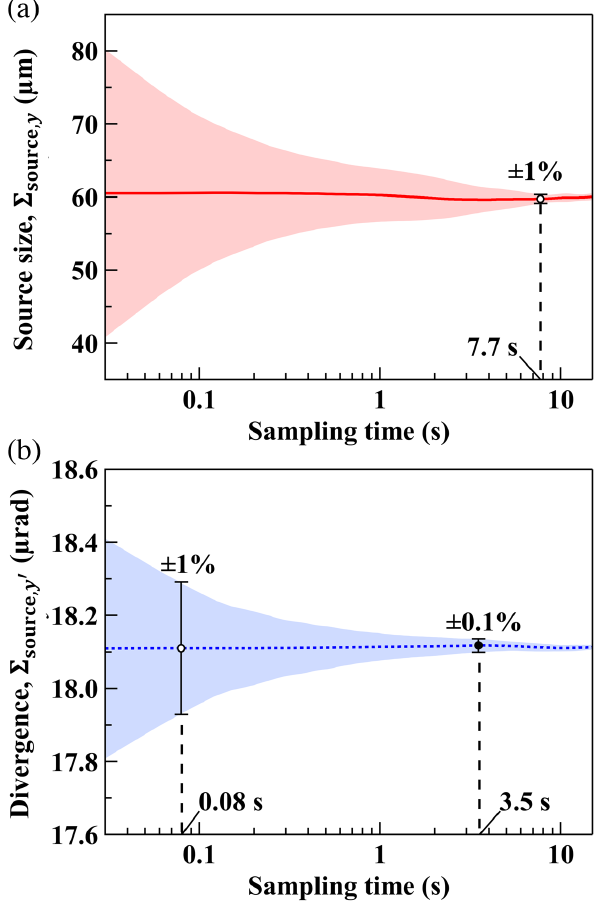
FIG. 7. Measured source size (a) and divergence (b) as a function of sampling time using the ps-BPM system. The colored shade shows the plus-minus standard deviation (STD) of 100 measurements. Dashed lines and markers indicate sampling time to achieve different measurement